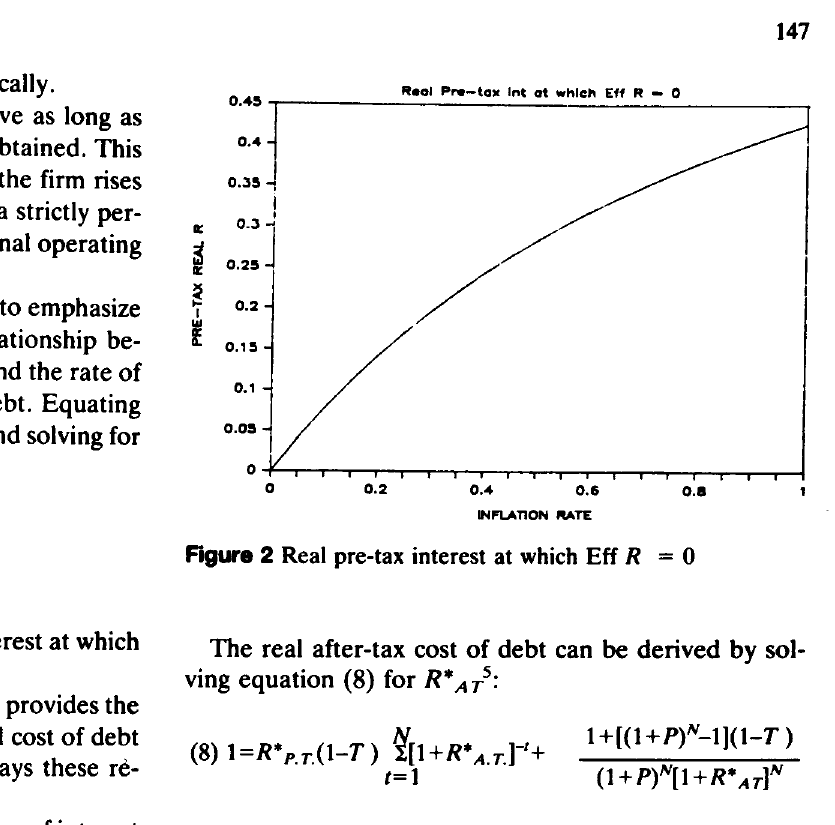
Figure 2 Real pre-tax interest at which Eff R = 0